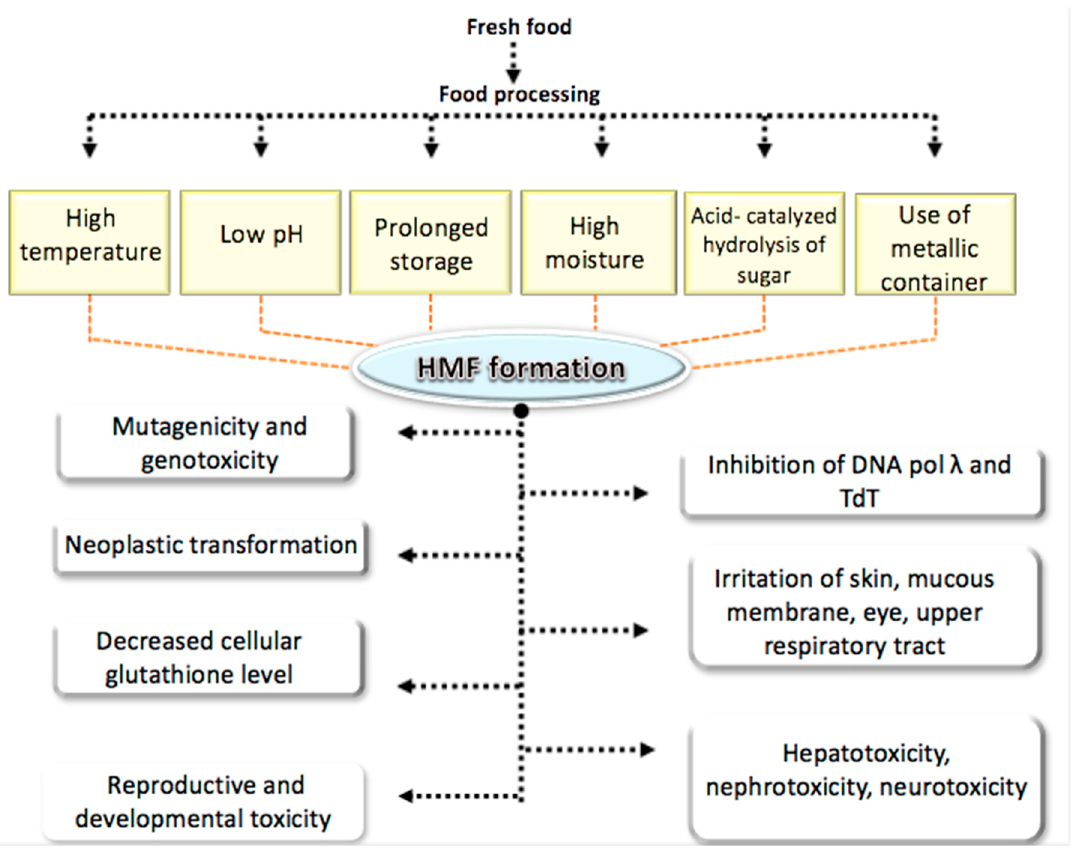
Figure 3. Adverse effect of HMF on human health. Figure 3. Adverse e ff ect of HMF on human